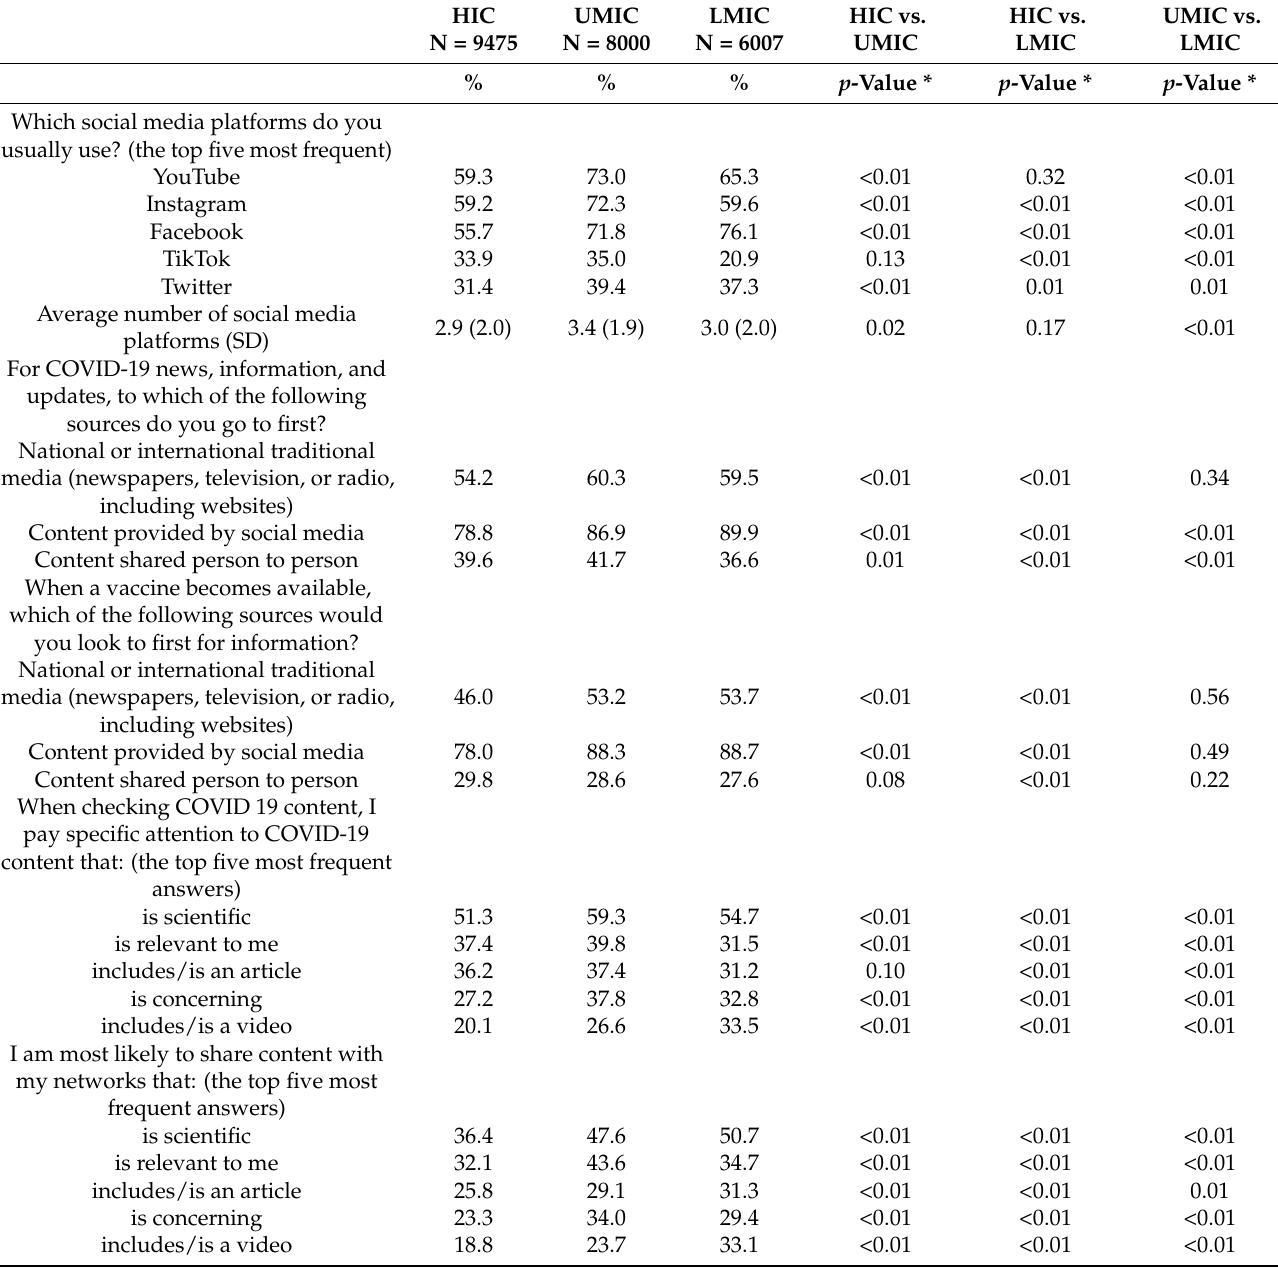
Table 2. Responses (%) of the 23,482 young respondents to the international survey “Social Media & COVID-19” about the social media platforms usually used, the sources of information regarding COVID-19 and its vaccine, and the characteristics of COVID-19 content and shared content in the three income groups (according to the World Bank classification of income level). HIC UMIC LMIC HIC vs. HIC vs. UMIC vs. N = 9475 N = 8000 N = 6007 UMIC LMIC LMIC % % % p -Value * p -Value